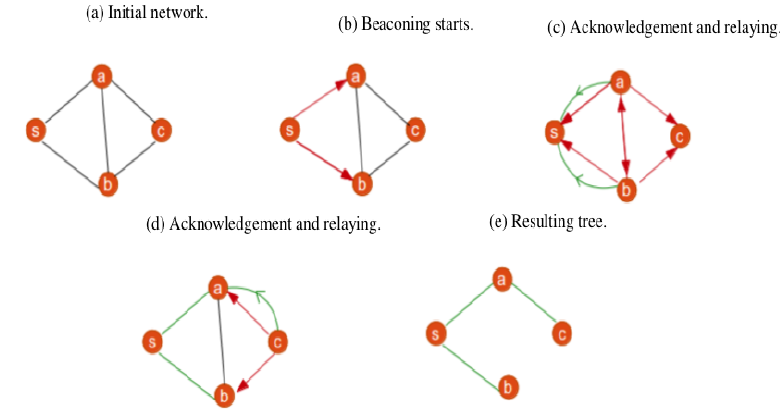
Figure 3. LIBP protocol